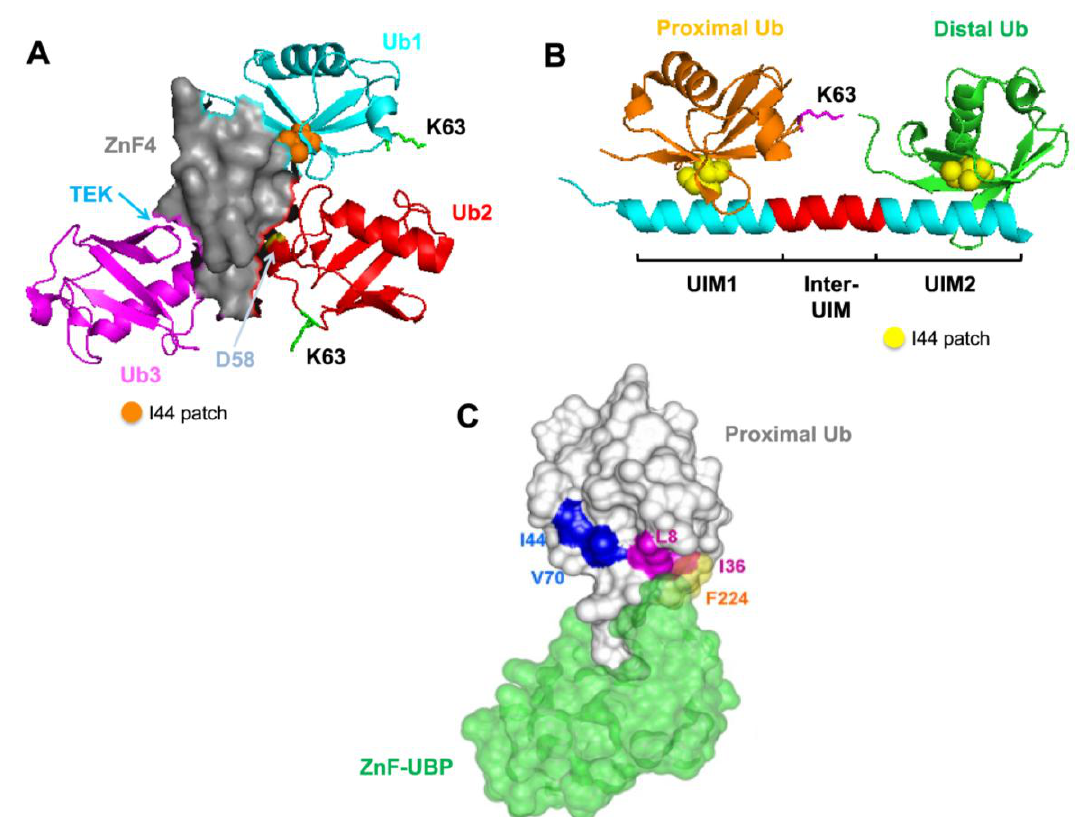
Figure 4. Recognition of specific Ub chains by UBD-containing